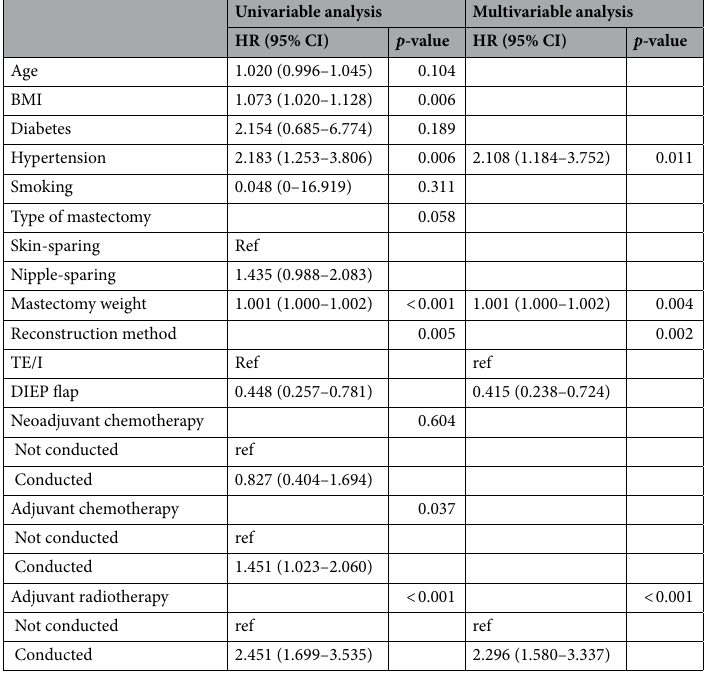
Table 3. Univariable and multivariable Cox-regression analysis for major complication. HR Hazard ratio, CI Confidence interval, BMI Body mass index, ref reference.